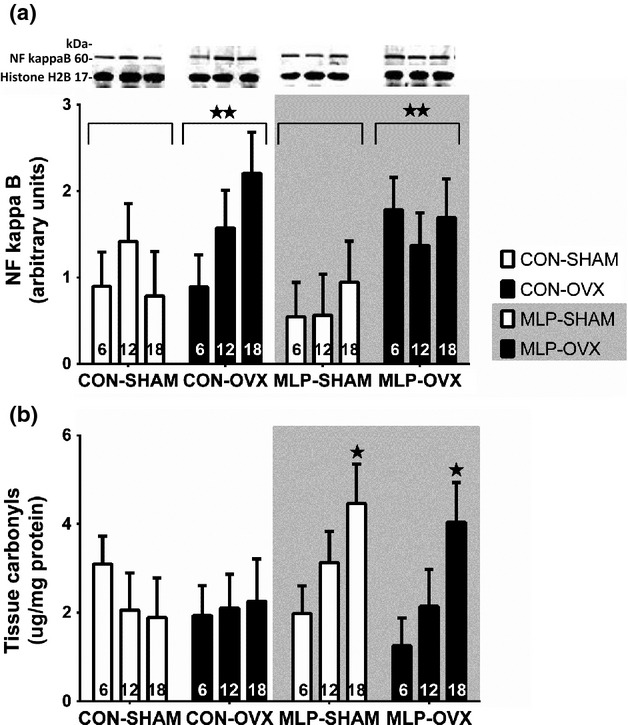
Western blot analysis and cropped images of NF-κB protein expression in the renal cortex at 6, 12, and 18 months and positive cell counts for CD3 marker in glomerulus collected at 6, 12, and 18 months. Animals were exposed to a control (CON) or low-protein (MLP) diet during pregnancy, with sham or ovariectomy (OVX) surgery at 10 weeks of postnatal age. White columns represent intact (SHAM) females and black columns represent ovariectomized (OVX) females. Data are presented as mean ± SEM for n = 8 in each group. There was a significant main factor effect of ovariectomy in increasing NF-κB protein expression (P < 0.005). Main factor effects of age, due to decreases after 6 months (P < 0.001***) and ovariectomy (OVX>SHAM, P < 0.05*) observed for CD.